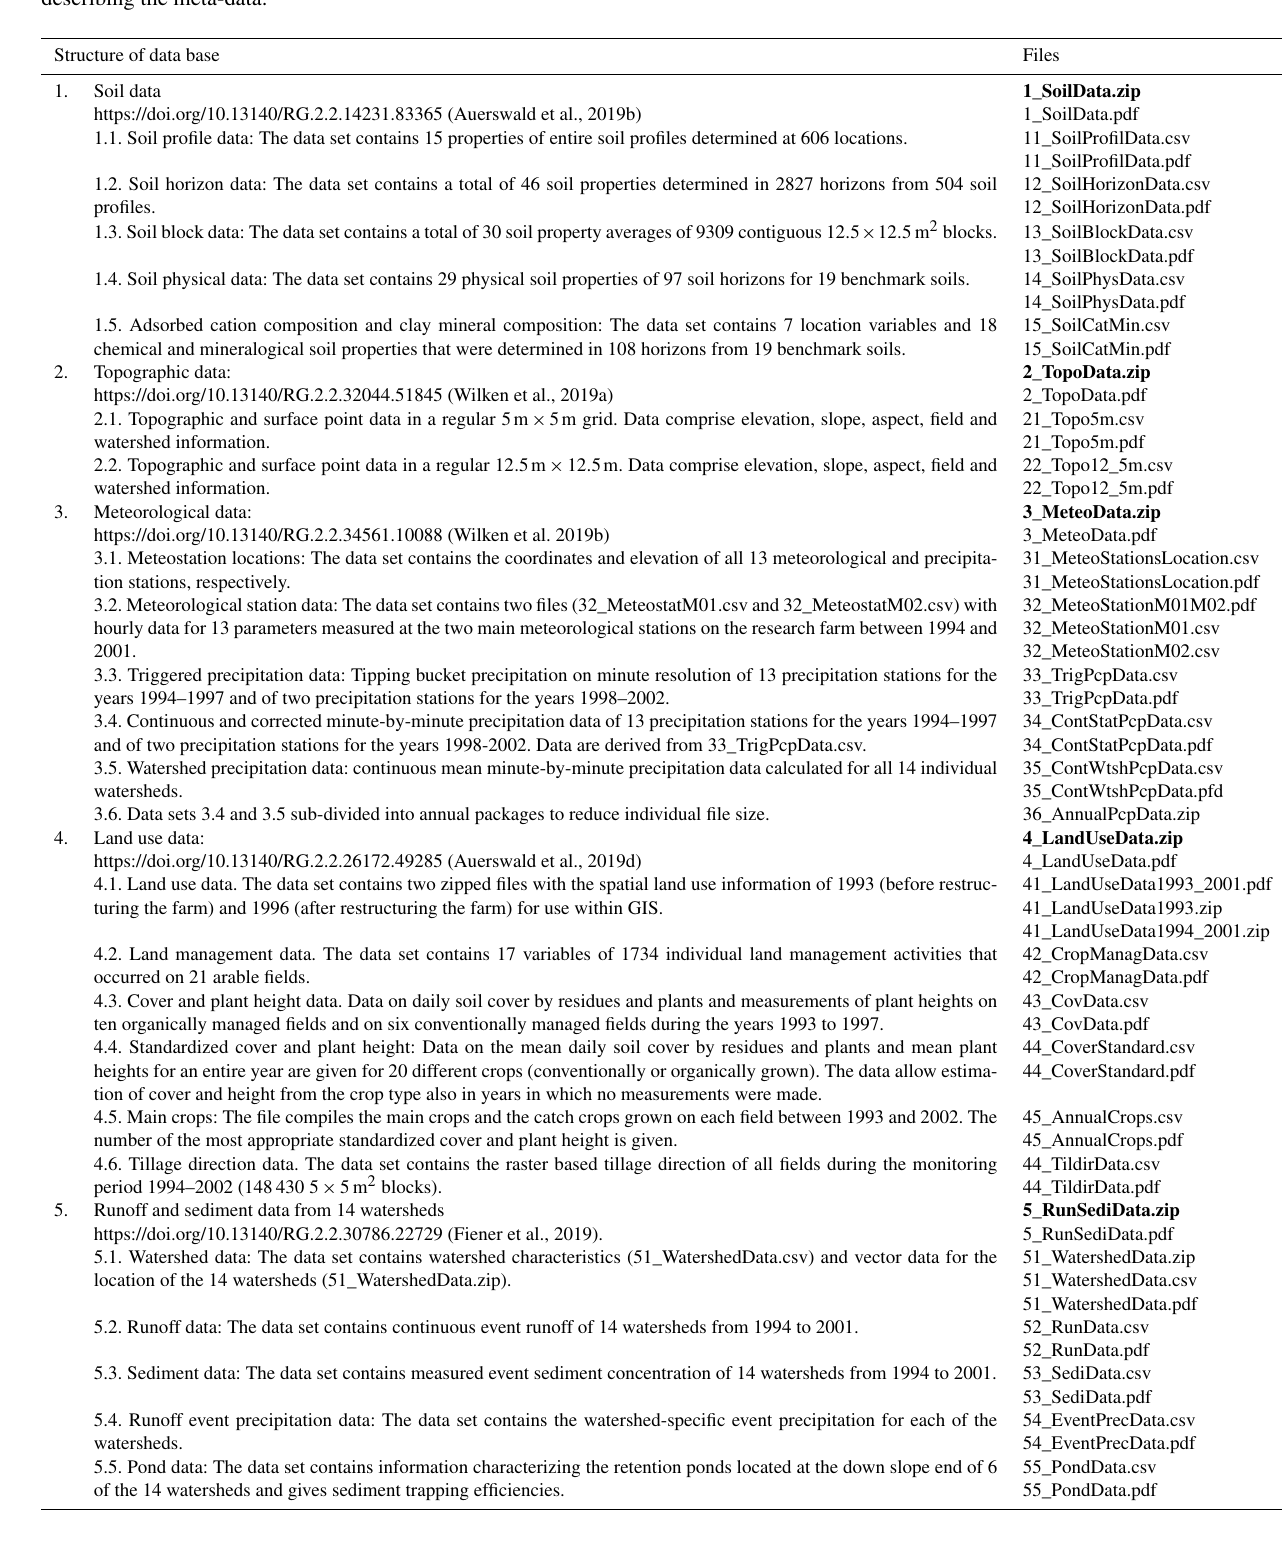
Table 1. Structure of the Scheyern data base. The zip-files (bold) combine all data and meta-data within one topic, with an individual DOI. Each zip-file contains several csv files with data, shape files (which are zipped) for geographic information and corresponding pdf files describing the